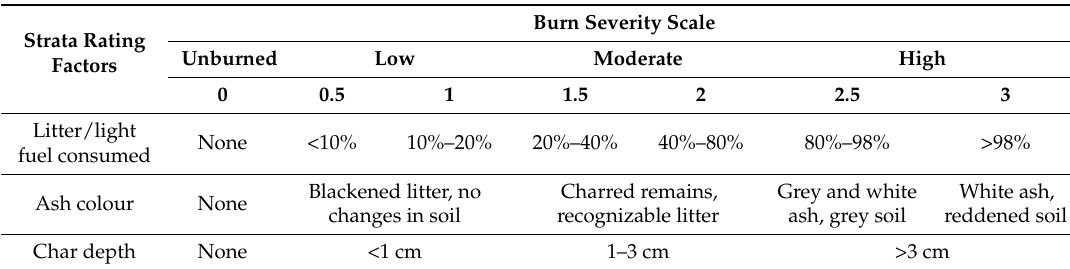
Table 2. Modified Composite Burn Index used in this study to obtain the field values of soil burn severity (based on Key and Benson